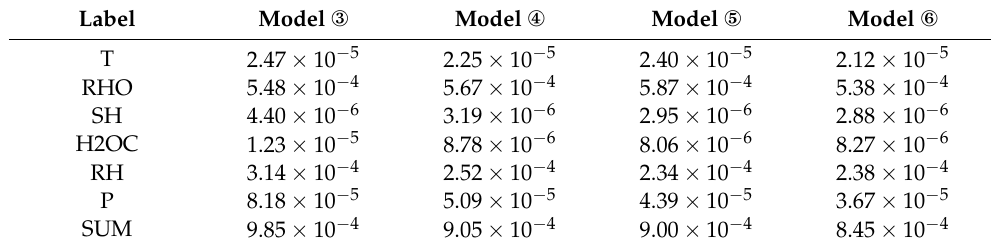
Table 4. MSE values for subtasks in the multitasking model. Label